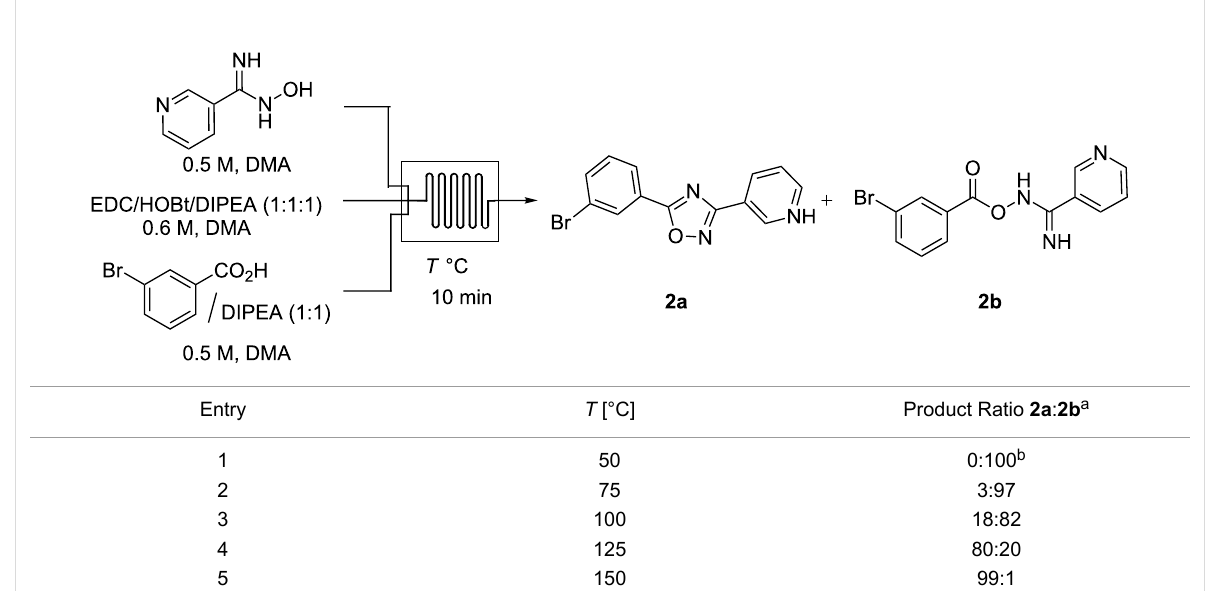
Table 1: Optimization of the flow synthesis of